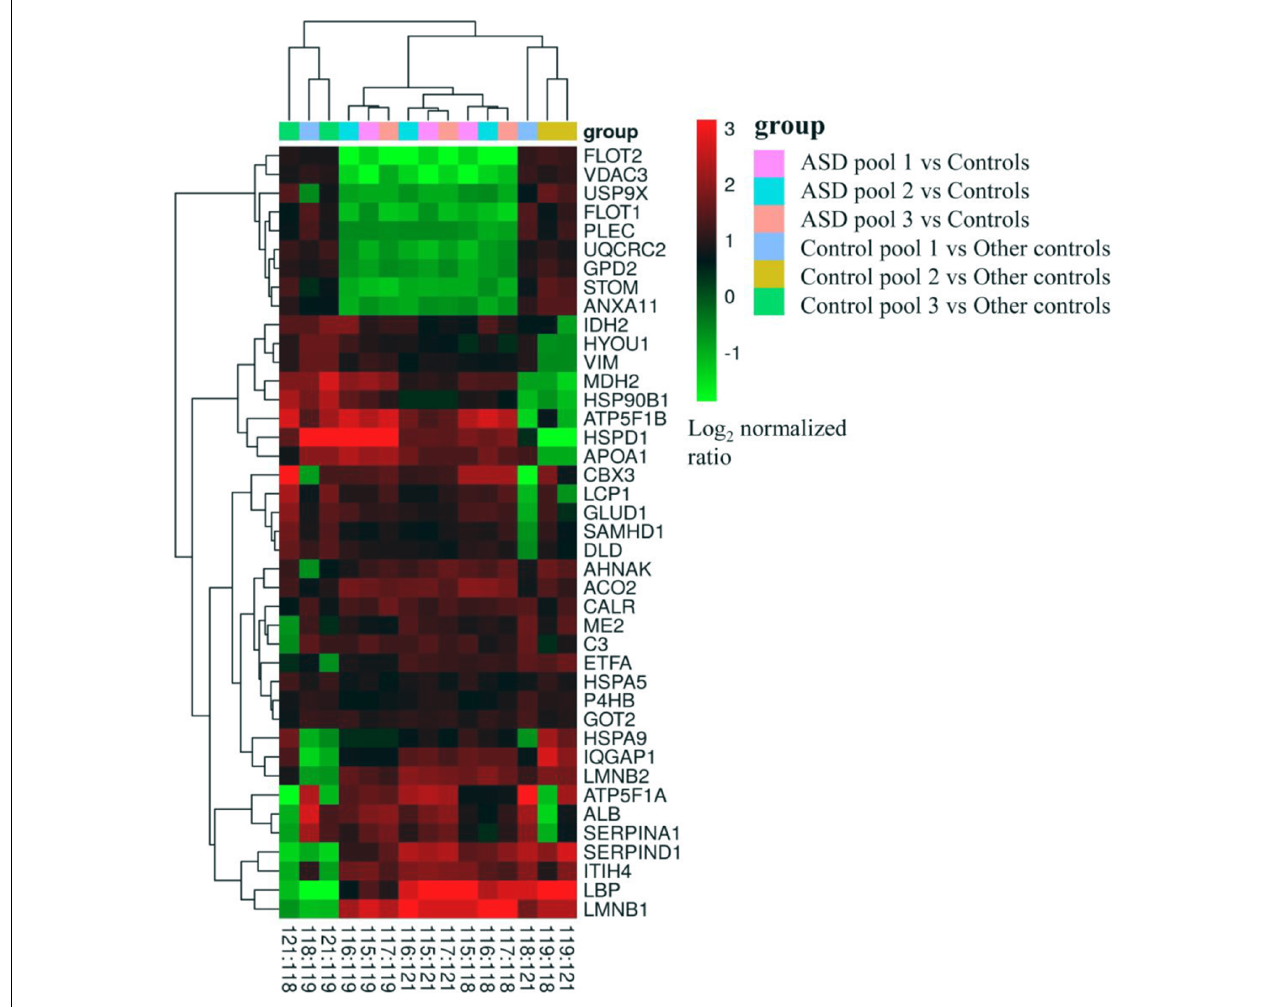
FIGURE 2 | Cluster map the differentially expressed proteins in all cross comparisons. Three mixed samples from autistic children were labeled with isobaric tags for relative and absolute quantitation (iTRAQ) tags 115, 116, 117, and the healthy controls with 118, 119 and 121 tags,